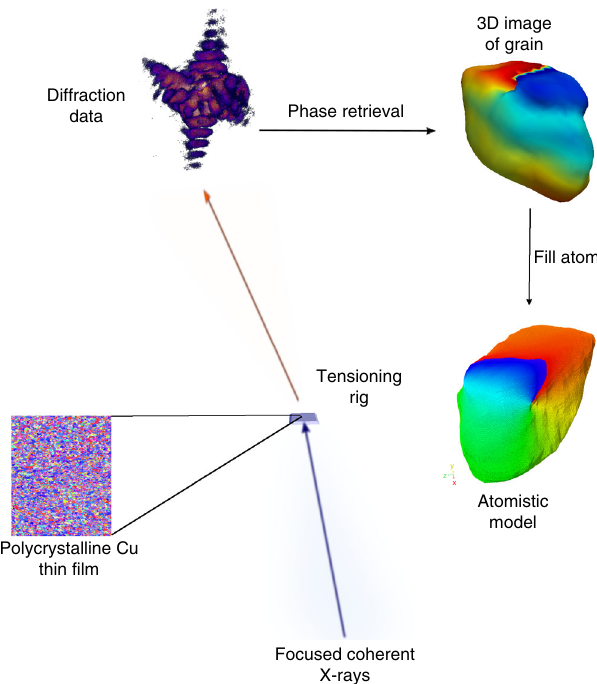
Fig. 1 Coherent X-ray diffraction imaging in Bragg geometry. Focused coherent X-ray pulses are incident on the polycrystalline Cu sample. Diffracted X-ray pulses are recorded in the far- fi eld by an ASI Timepix detector. The three-dimensional speckle pattern at the (111) Bragg peak is recorded from 2-D diffraction slices obtained by rocking the sample stage through small angles (~1 0